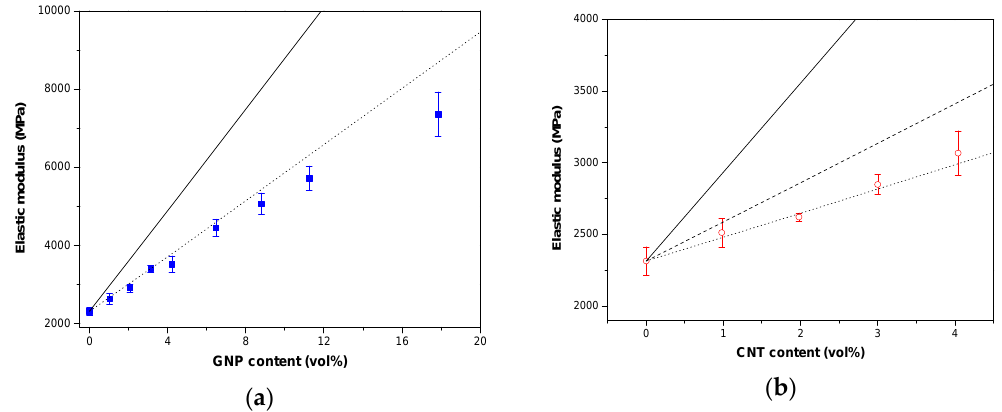
Figure 5. Elastic modulus of nanocomposites ABS/GNP ( a ) and ABS/CNT ( b ), evidenced in blue and red symbols, respectively. Continuous ( ___ ) and dash lines ( _ _ _ ) and dot lines ( ··· ) represent prediction according to the Halpin-Tsai models with parallel, 2D random and 3D random orientation, respectively.